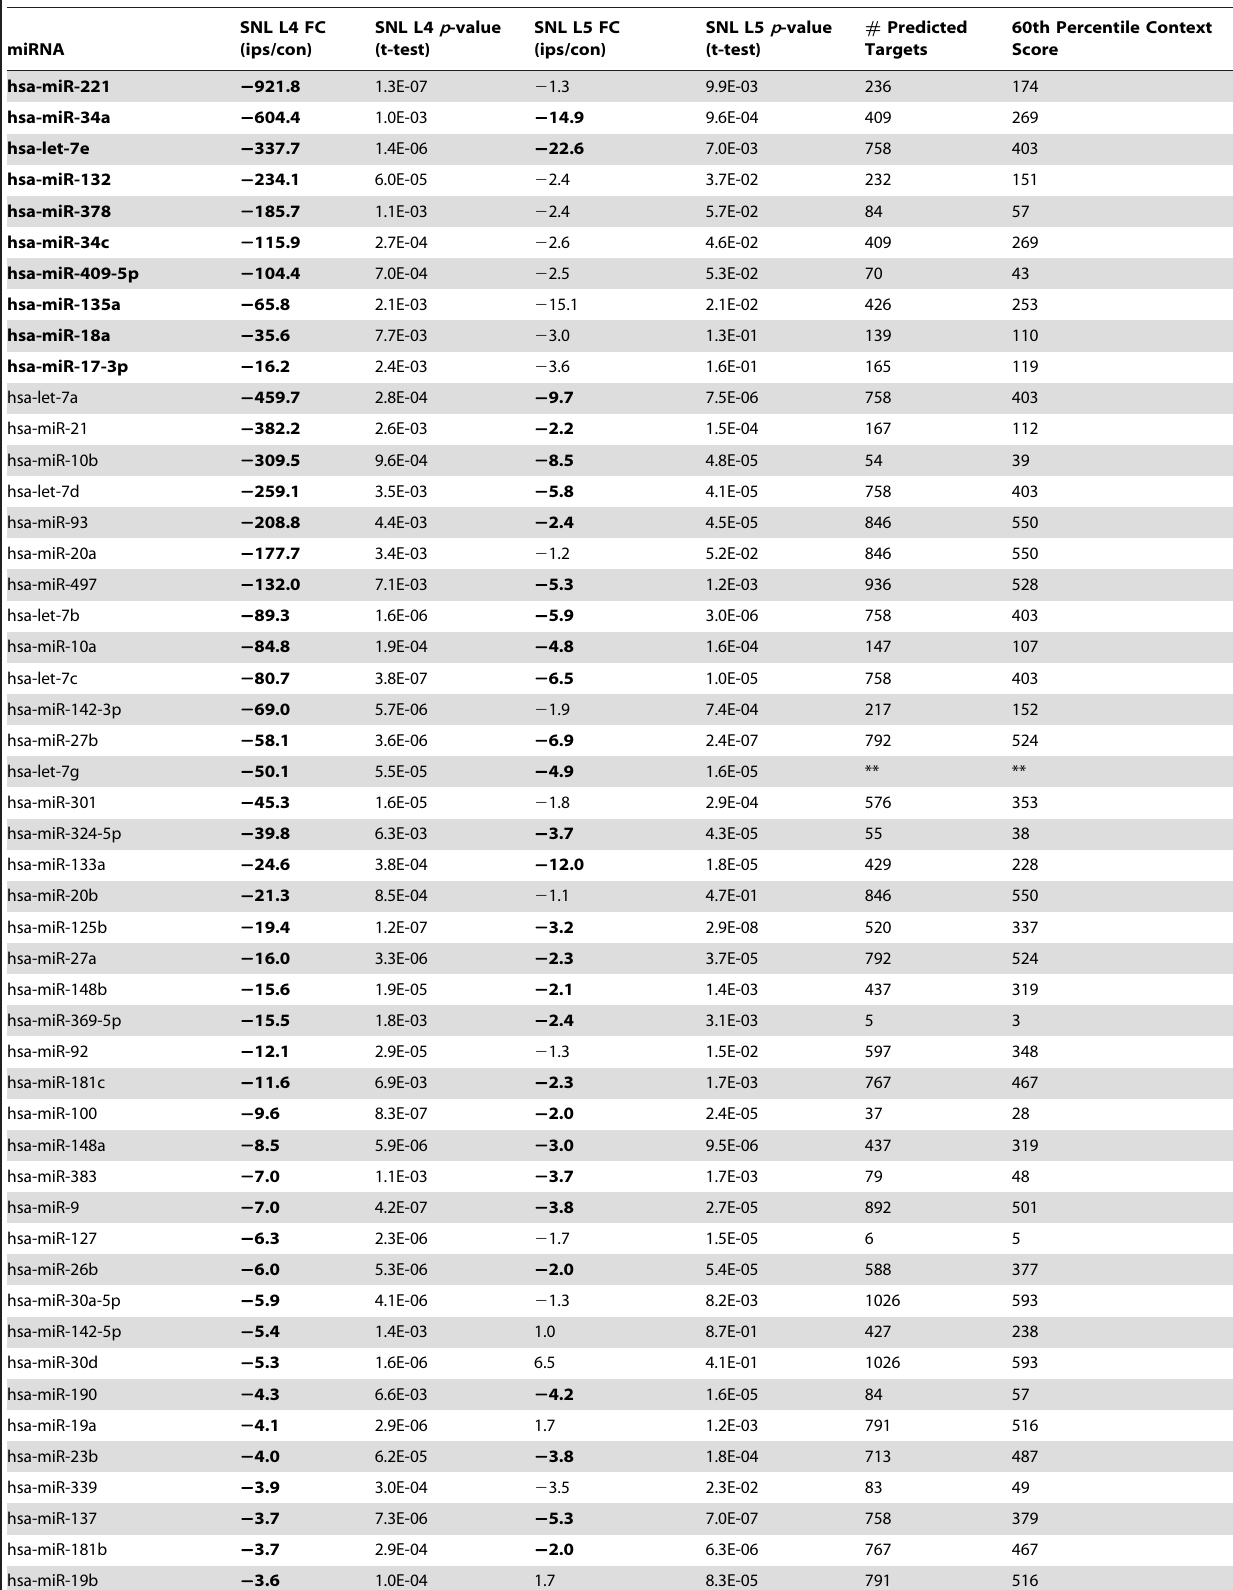
Table 1. Sixty three miRNAs significantly altered following SNL surgery.